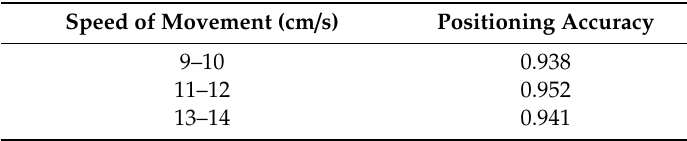
Table 4. Speeds of movement.